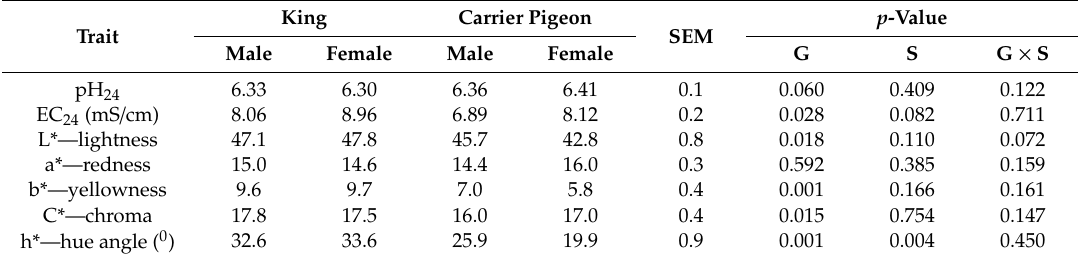
Table 4. Selected physicochemical traits of the pectoralis major muscle in three-year-old pigeons of di ff erent genotypes.